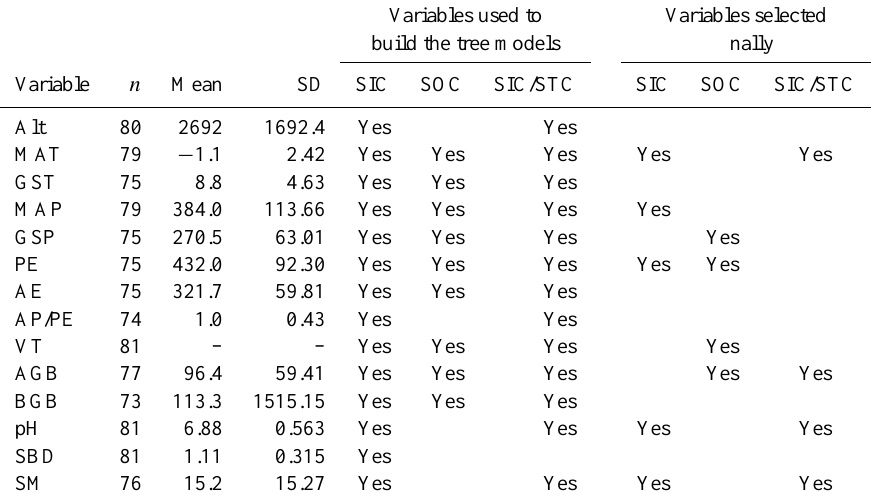
Table 4. Variables included and selected in the regression tree analysis. Alt=altitude; MAT=mean annual temperature; GST=growing season temperature; MAP=mean annual precipitation; GSP=growing season precipitation; PE=potential evapotranspiration; AE=actual evapotranspiration; AP/PE=the ratio of MAP to PE; VT=vegetation type; AGB=aboveground biomass; BGB=belowground biomass; SBD=soil bulk density; SM=soil moisture. Variables used to Variables selected build the tree models